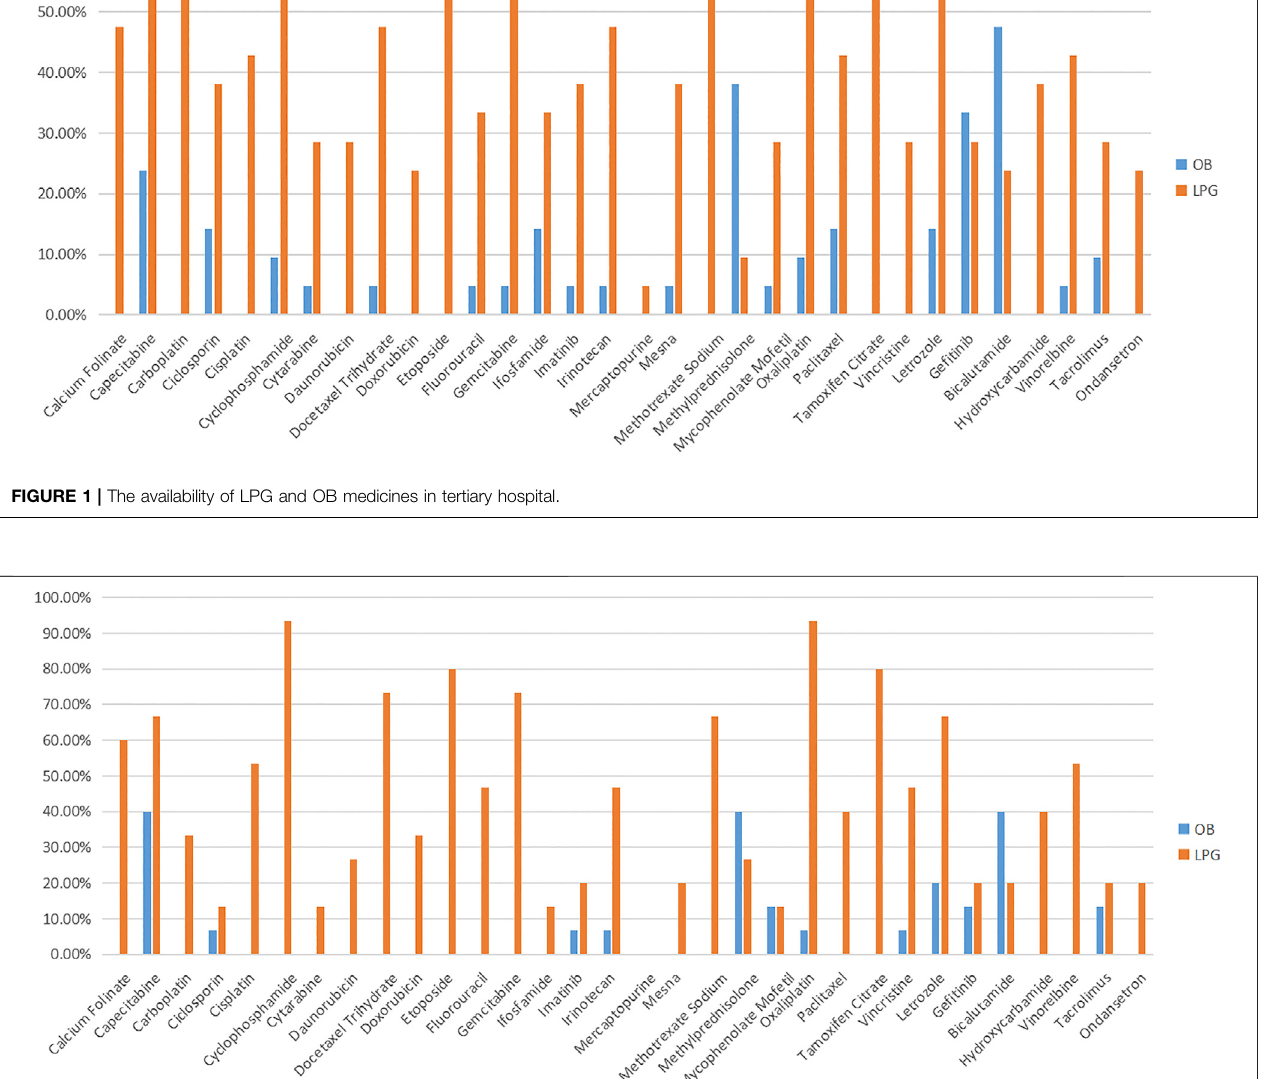
Frontiers in Pharmacology |